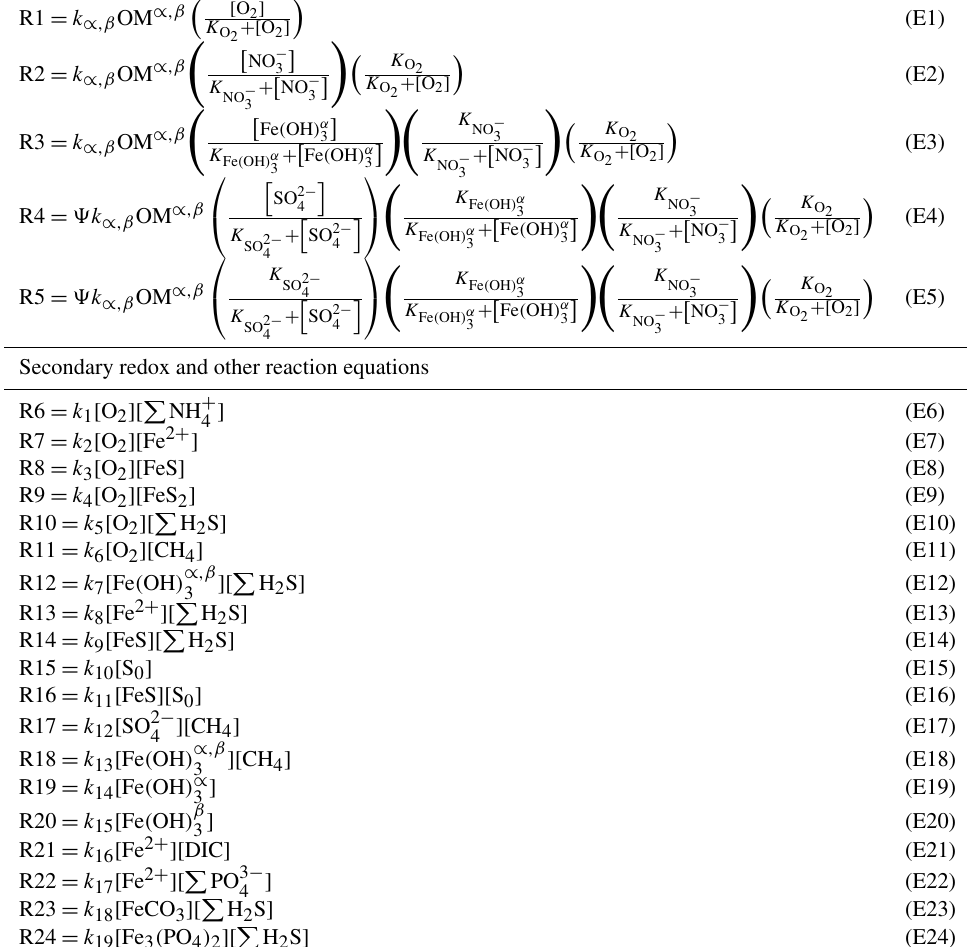
Table 6. Reaction equations implemented in the model. Primary redox reaction